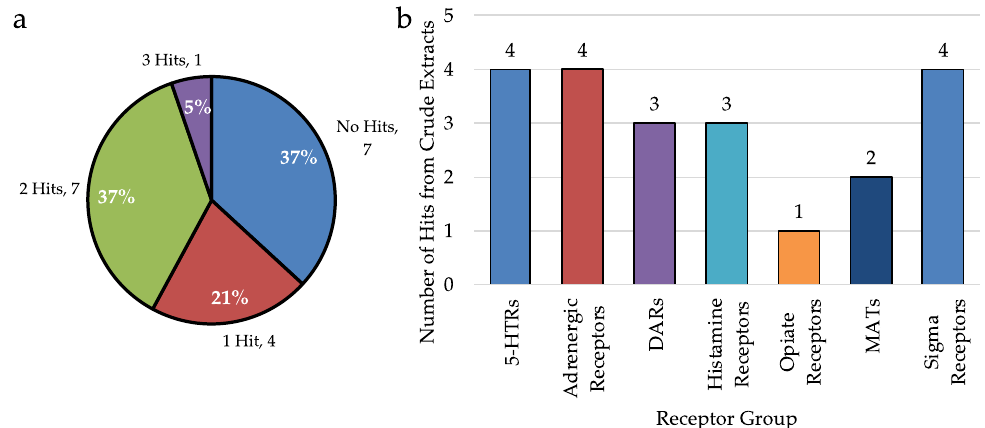
Figure 2. Analysis of biological data from only the crude extracts, before fractionation. ( a ) Analysis of the number of hits per crude extract. Few hits are detected when only the crude extracts are analyzed. ( b ) Number of hits detected from crude extracts at selected receptor groups.